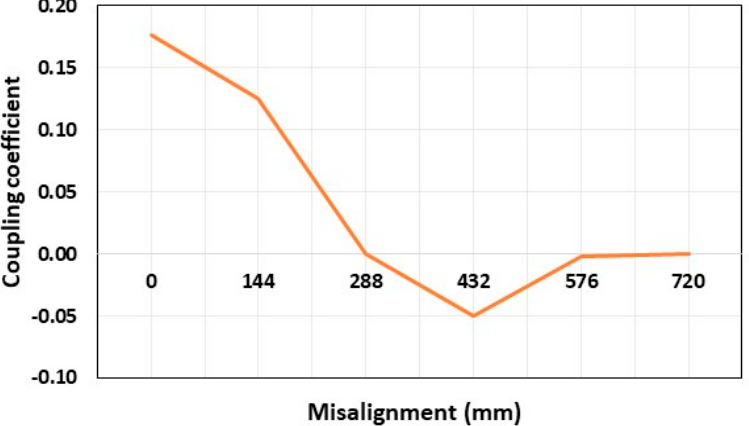
Figure 14. Variation of the coupling coefficient (k) as a function of the misalignment along the y-axis for the DD–DD configuration.